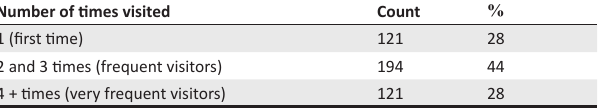
TABLE 3: Visitors at the Kruger National Park based on frequency of visitation. Number of times visited